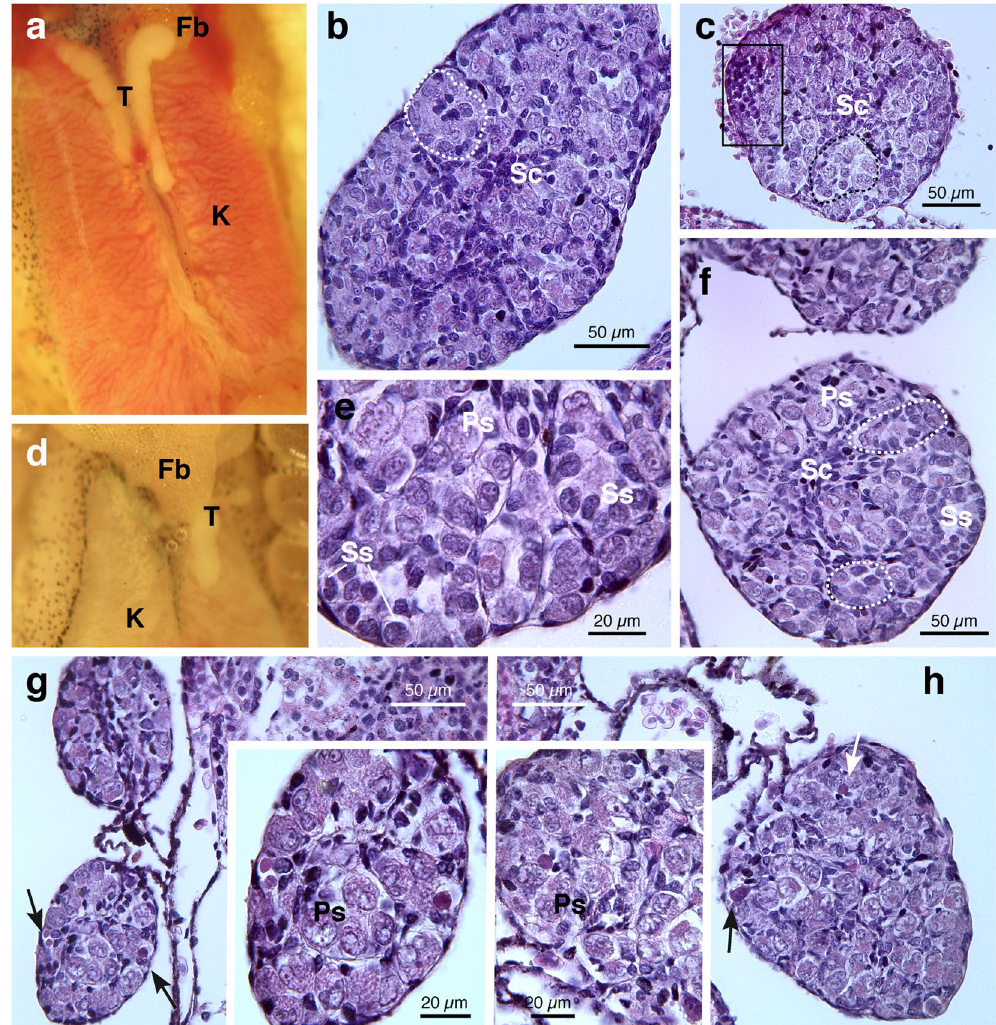
Figure 4. Representative photomicrographs and histological sections of phenotypic males of H . intermedia juveniles after exposure to pyrimethanil. Testes from animals exposed to 5 µ g/L ( a – d ) and 50 µ g/L ( e – h ). ( a ) Testicular normal gross appearance in exposed animal. ( b , e , f ) Cross-sections showing well preserved testicular tissue with primary and secondary spermatogonia within seminiferous tubules (marked by dotted lines). ( c ) Note the presence of mononuclear cells infiltration (marked by rectangle). ( d ) Macroscopic ventral view of a specimen with only one left testis with reduced dimension. ( g , h ) In some treated animals seminiferous tubules tend to be less organized and alterations of testicular tissue are detected: including enhancement of the intercellular spaces, primary spermatogonia/germ cells showed hydropic tumefaction or signs of focal necrosis (arrows). Details of interest are magnified in the inset. (T = testes; K = kidney, Fb = fat body; Sc = somatic cells; Ps = primary spermatogonia; Ss = secondary spermatogonia). All sections are